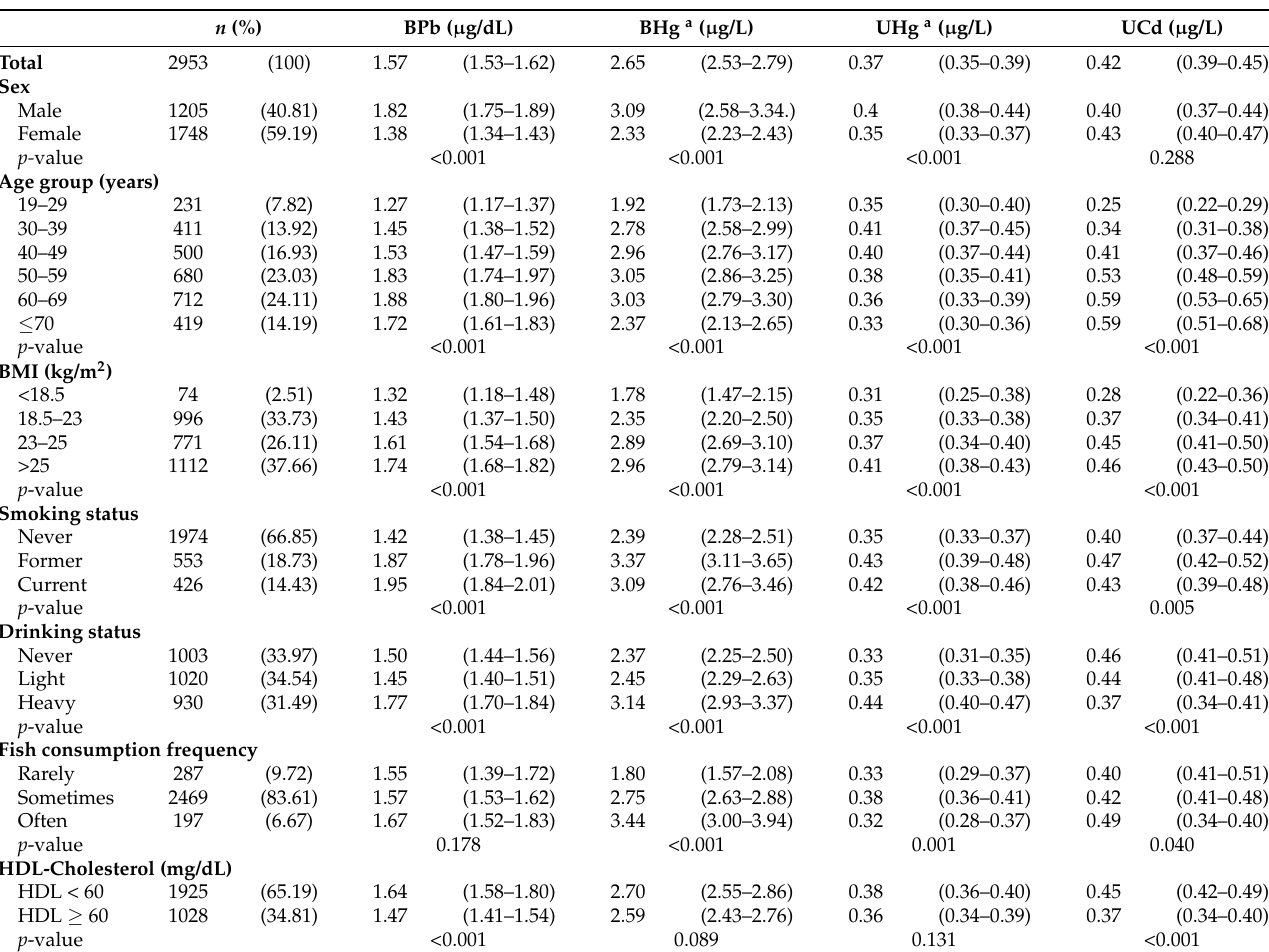
Table 1. The descriptive statistics of demographic characteristics and geometric means (95% CI) of heavy metal concentra- tions in